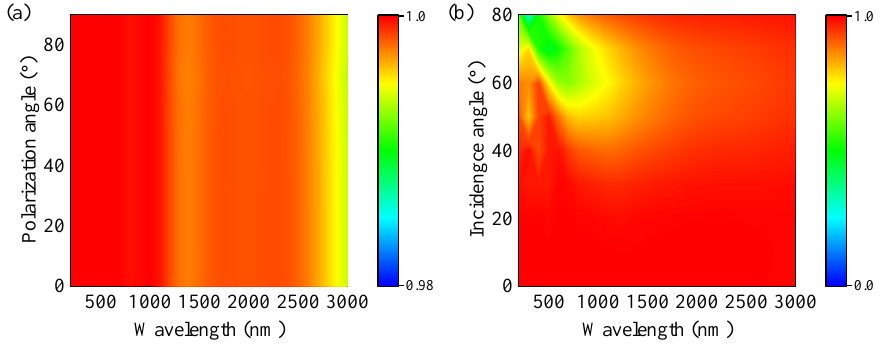
Figure 7. Absorption diagrams of the proposed solar energy absorber by tuning polarization ( a ) and incident angle ( b ).